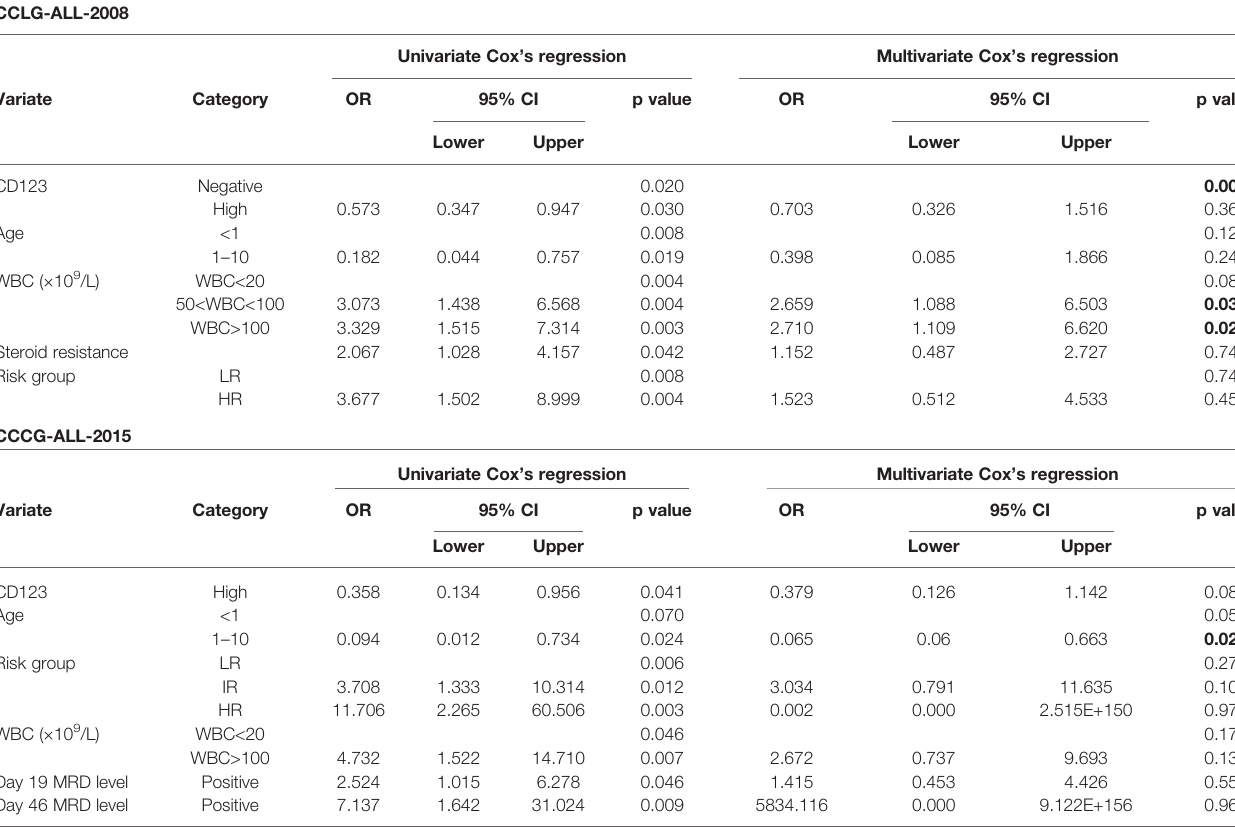
Bold numbers represent that p value reaches statistical signi fi